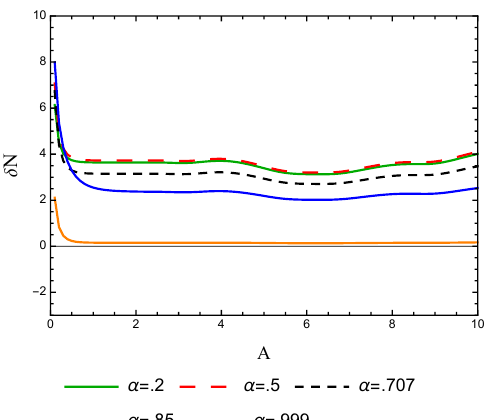
plot for different a A